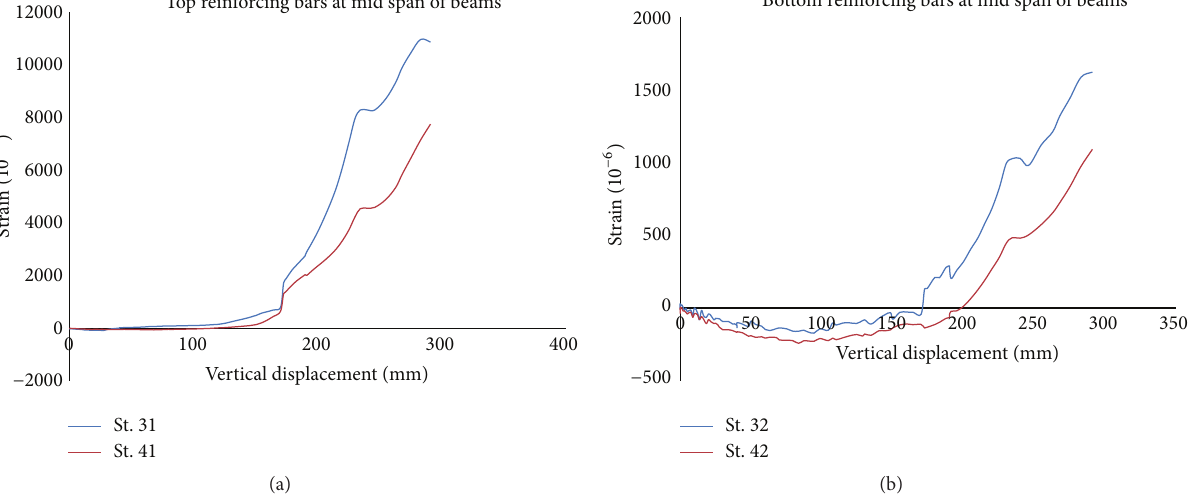
Figure 13: Strain in bars at beam mid span versus vertical displacement of middle joint.